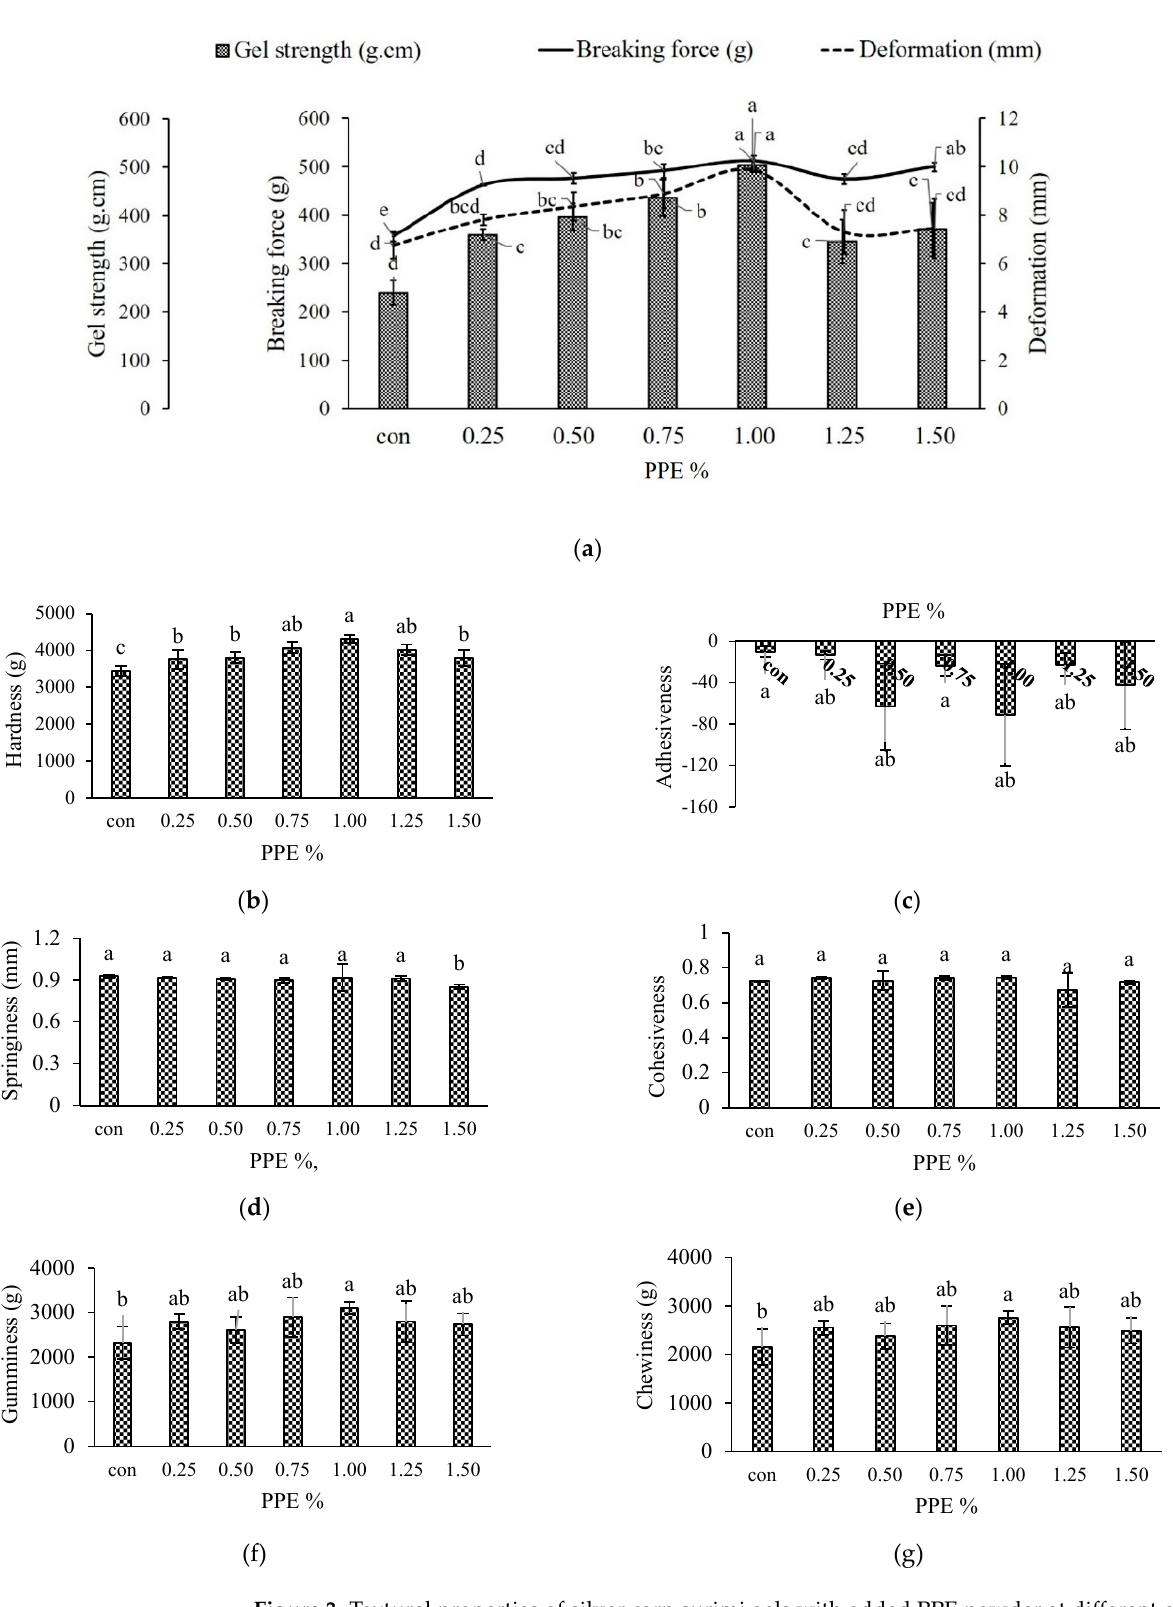
Figure 3. Textural properties of silver carp surimi gels with added PPE powder at different concentrations (0-1.5% w / w ). Gel strength ( a ), hardness ( b ), adhesiveness ( c ), springiness ( d ), cohesiveness ( e ), gumminess ( f ) and chewiness ( g ); con (control)-without PPE. Different letters (a, b, c, etc.) on the bars indicate significant differences ( p <